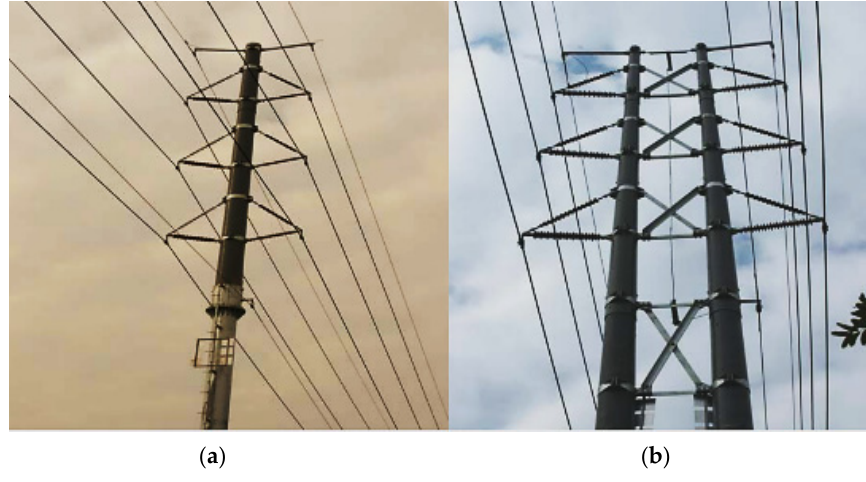
Figure 9. ( a ) 110 kV tower of combined composite single ‐ pole double ‐ circuit material and ( b ) 110 kV tower of complete composite double ‐ pole double ‐ circuit material [31].